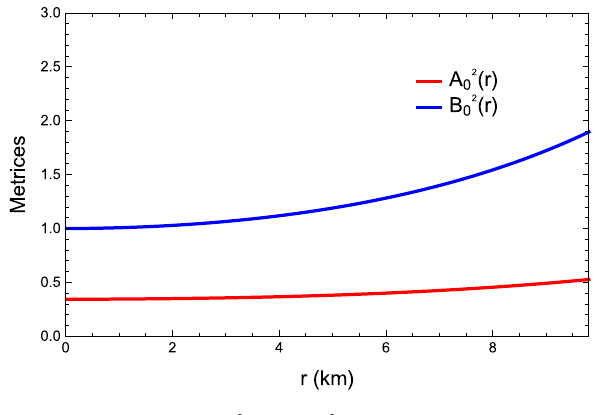
The radial and tangential pressures also radially decrease outwardtoitsboundaryfromitsmaximumvalueatthecenter. The radial pressure drops to zero at the boundary, but the tangential pressure remains nonzero at the boundary. The central density, central radial pressure, and central tangential pressure in this case are given